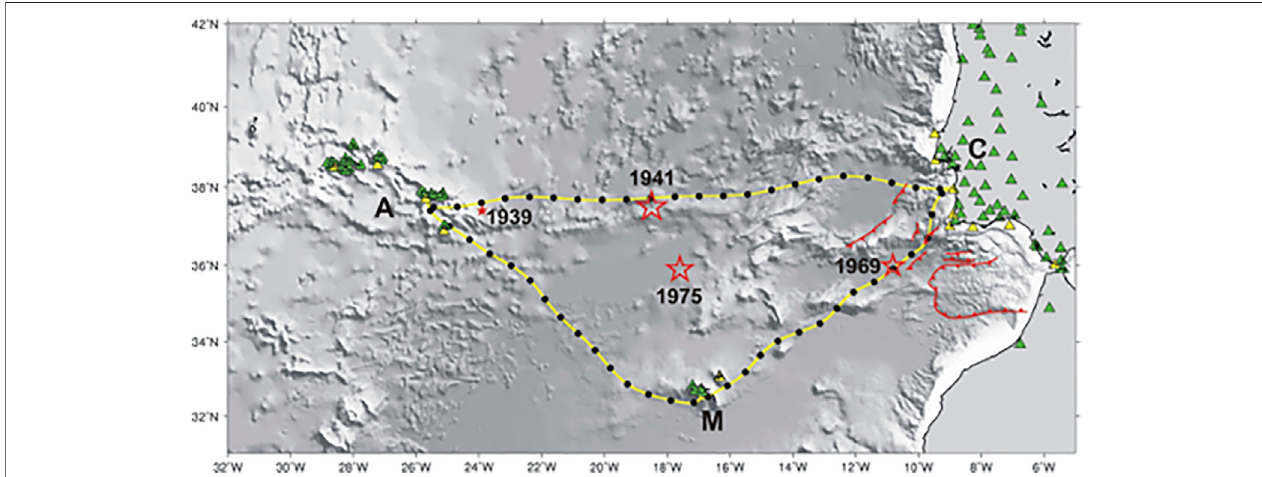
FIGURE14 | Nominal route for the new CAM submarine cablewith SMART repeaters (black dots), spaced ∼ 70 km. The cables are identi fi ed by the landing points on both ends, C for the Portuguese mainland, M and A for the Madeira and Azores Archipelagos, respectively. The green triangles denote seismic stations currently monitored by the Instituto Português do Mar e da Atmosfera (IPMA). The yellow triangles show the location of coastal tide-gauges monitored by IPMA. The red stars show the location of 3 M > 7.7 large tsunamigenic earthquakes that occurred in the 20th century. The location of the November 1, 1755 earthquake is uncertain, and the faults shown (red lines) have been proposed as its